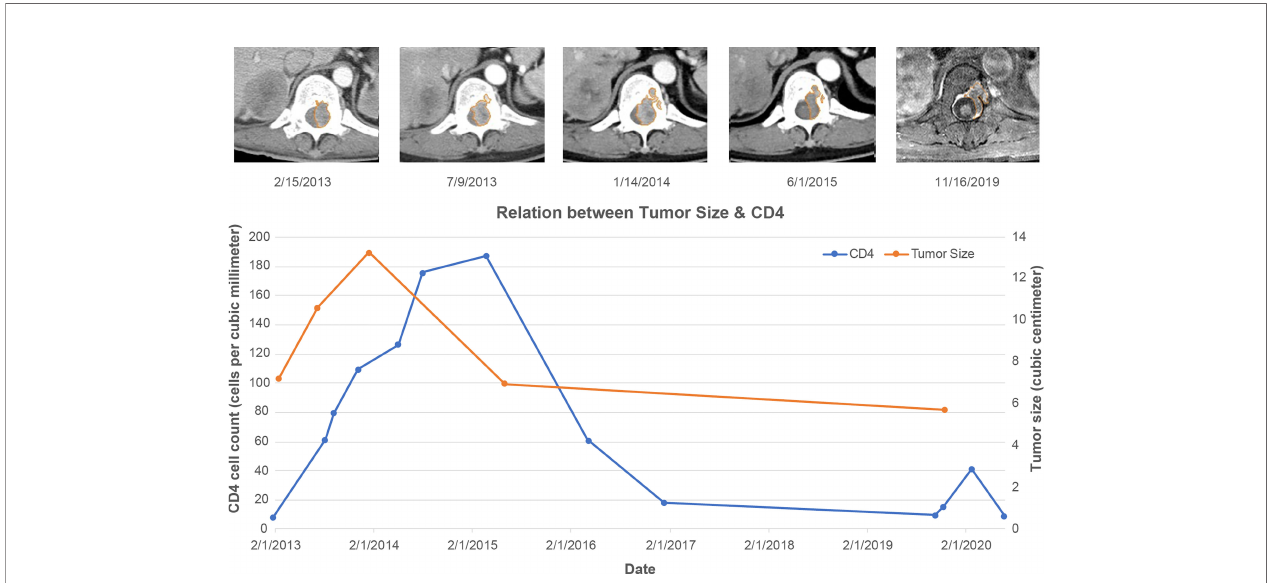
FIGURE 1 | Relationship of T11 Tumor Size with CD4 Count. The size of the tumor slowly increases until it peaks at 01/14/2014, despite elevated CD4 levels during the 2013 to 2015 period. The tumor then begins to decrease in size. Upper row: Abdominal computed tomography and magnetic resonance imaging (MRI) at different time points showing an Epstein-Barr virus-associated smooth muscle tumor at the T11 level, and the tumor size is highlighted with an orange line. The MRI of the tumor at the right end shows that the tumor has no mass effect on the spinal